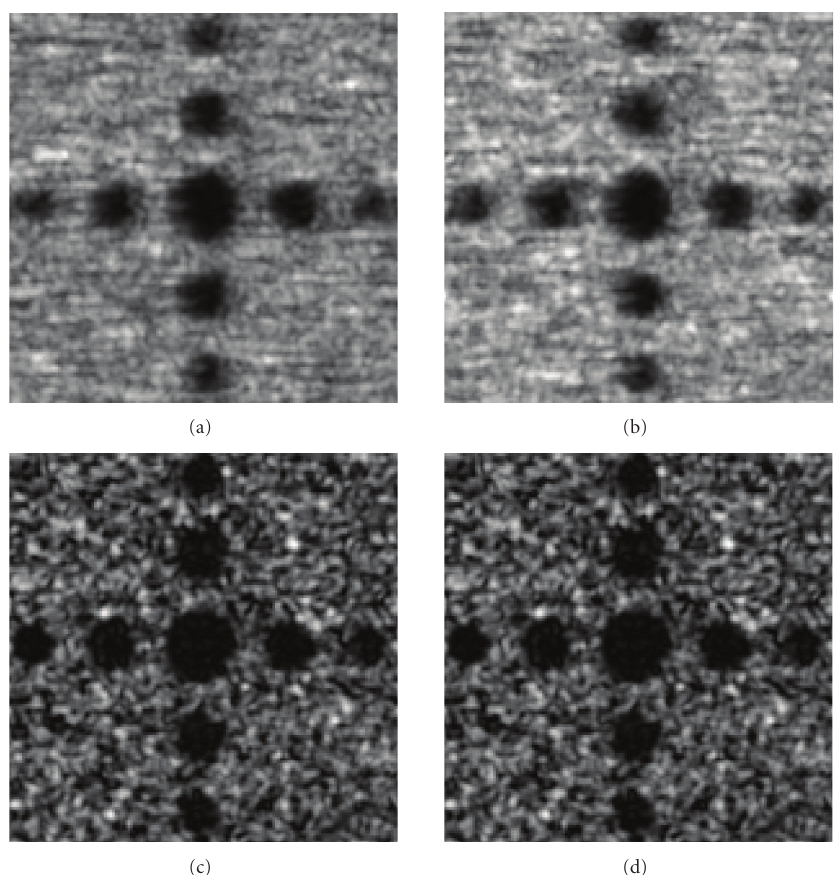
Figure 8: Comparison of compounded 3D ultrasound images by two methods: (a) cross-sectional view of the dataset by conventional method, (b) sagittal view of the dataset by conventional method, (c) cross-sectional view of the dataset by MMSE method, (d) sagittal view of the dataset by MMSE